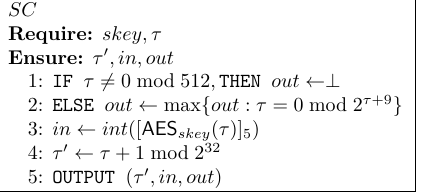
Figure 21: NROB : A Secure